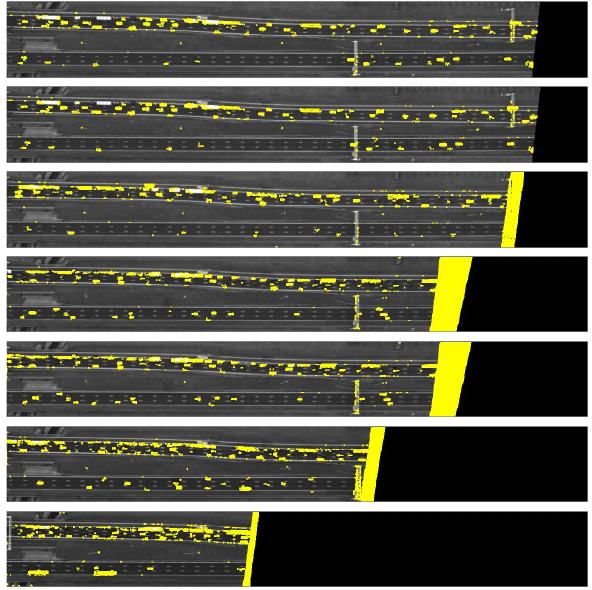
Figure 7: Identified vehicles: top to bottom: image number 100, 101, 248, 500, 501, 1000 and 1500.